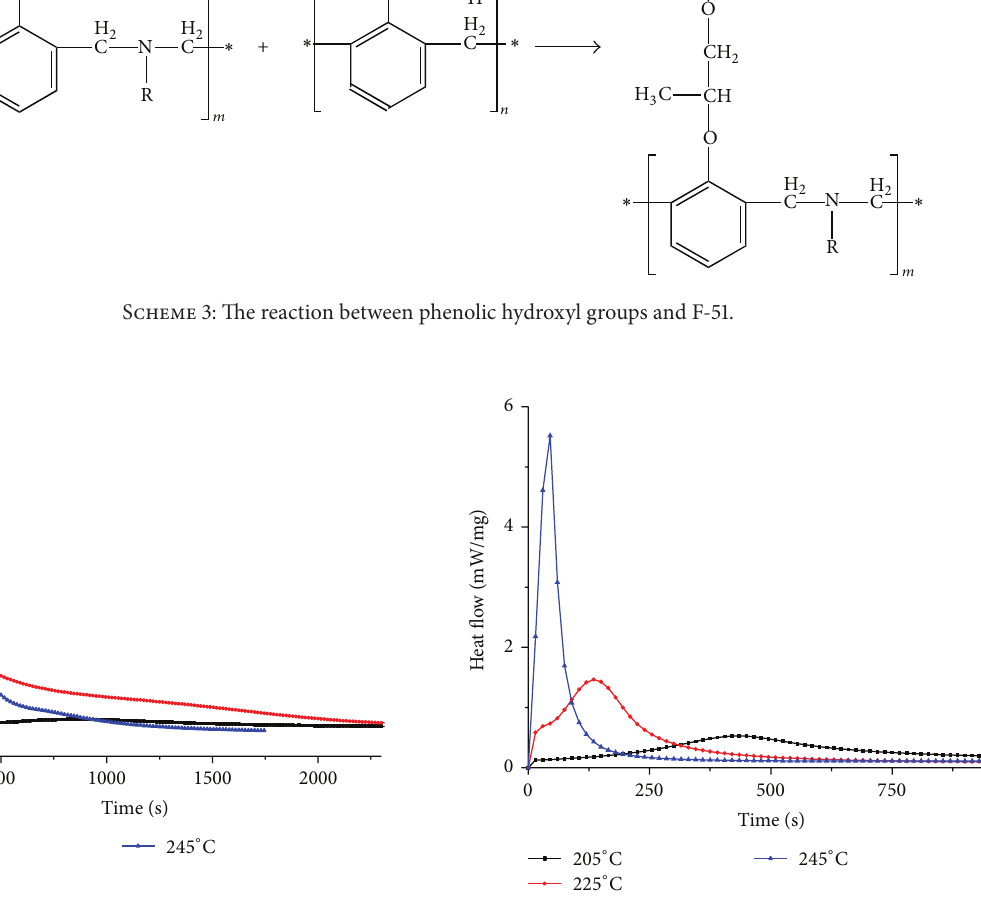
Figure 1: Isothermal curing DSC curves of BZ/F-51 hybrid net- works.